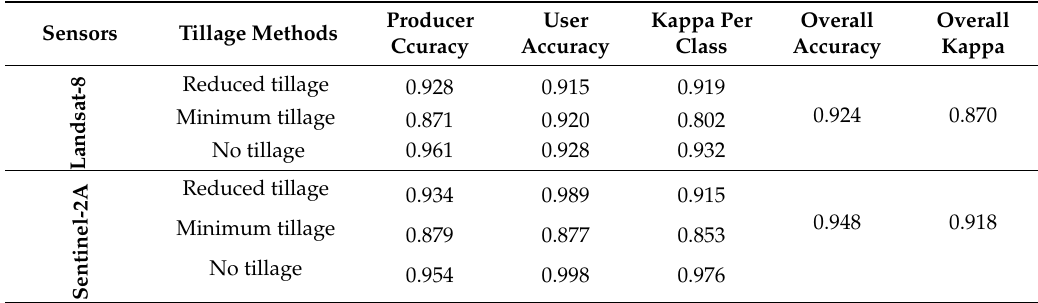
Table 6. Accuracy assessment of object-based image analysis (OBIA) membership function classification for Landsat-8 and Sentinel-2 images.